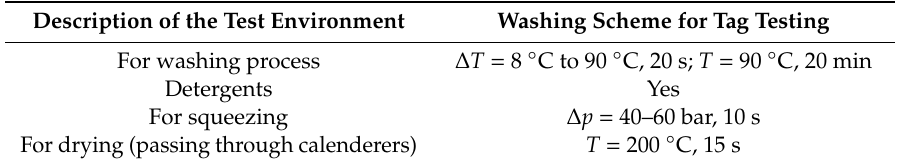
Table 3. Parameters for wash cyclic test.